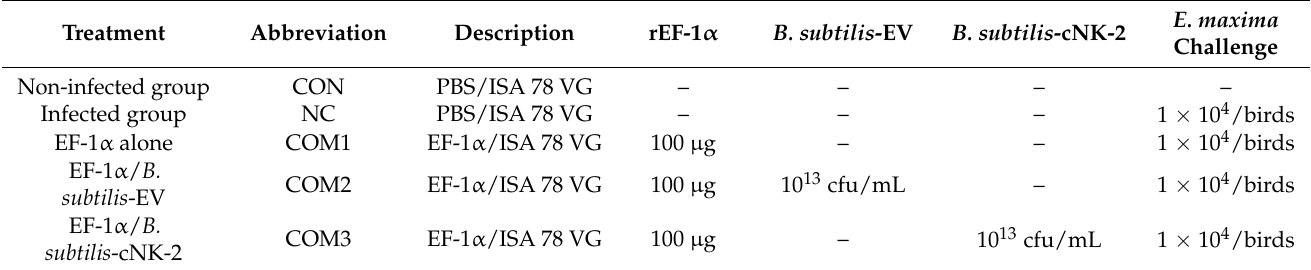
Table 1. Group information, immunization and Eimeria challenge infection